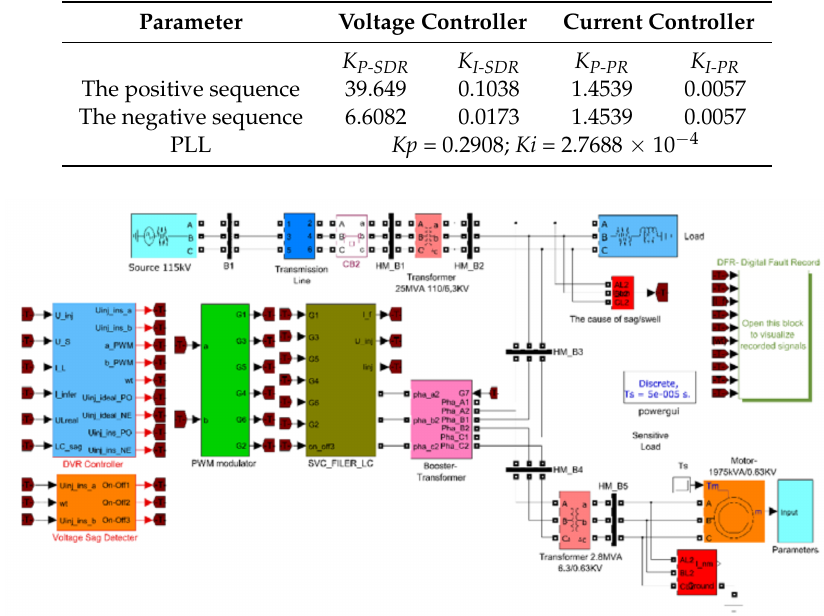
Figure 9. The MATLAB-Simulink model of our test system.